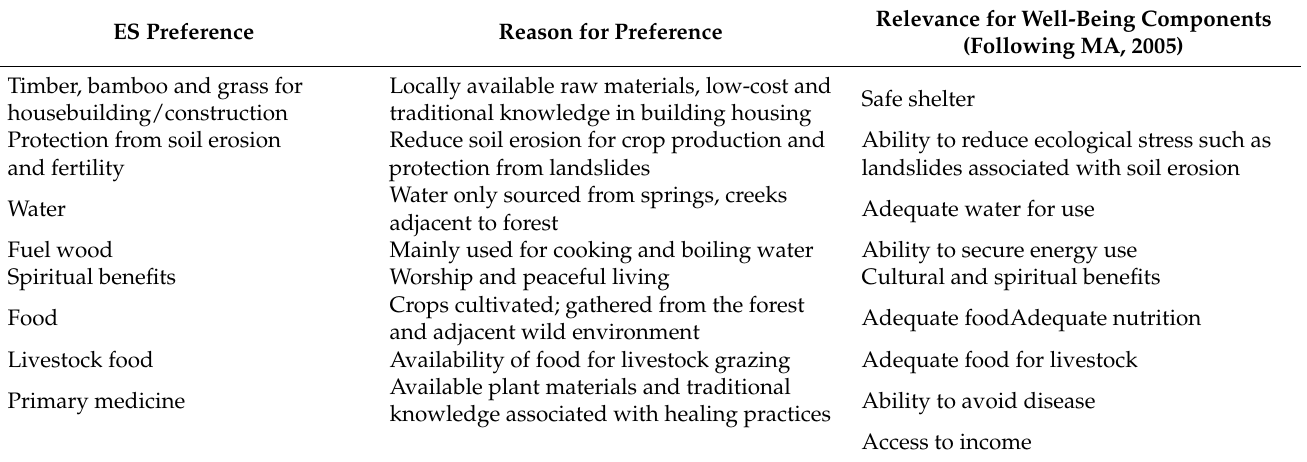
Table 3. Local community’s identification of ES, the reason for preference and linkage to